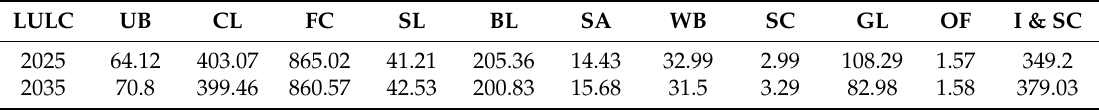
Table 6. Distribution of land-use categories (in km 2 ) and percentage of the categories for 2025–2035.